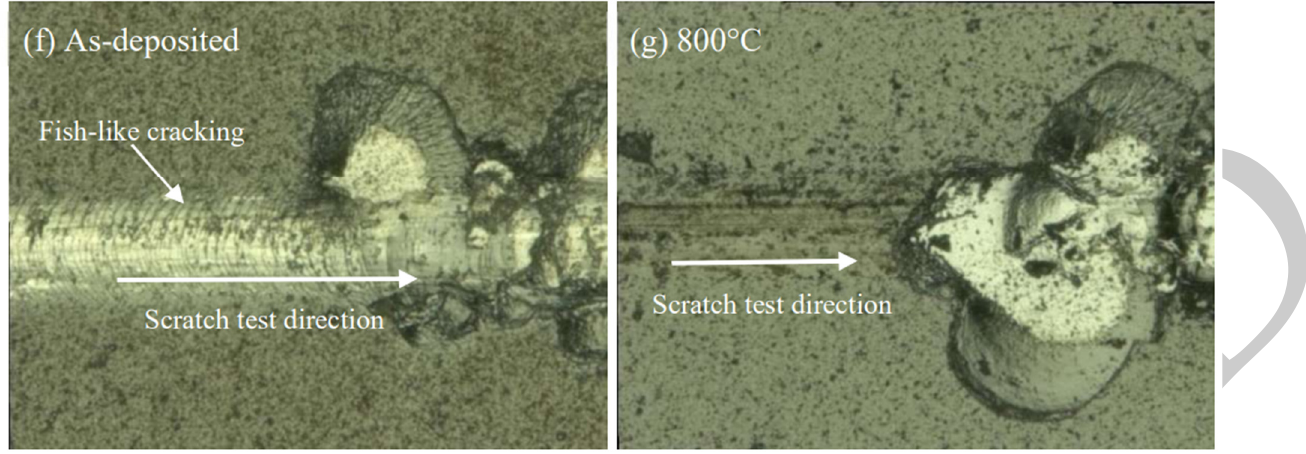
Figure 8. Scratch morphologies of the AlCrTiSiN coatings before and after annealing: ( a ) the range of normal load is 0–120 N, ( b – e ) the range of normal load is 0–80 N; locally amplified scratch morphologies ( f ) as deposited, ( g ) annealed at 800 °C.